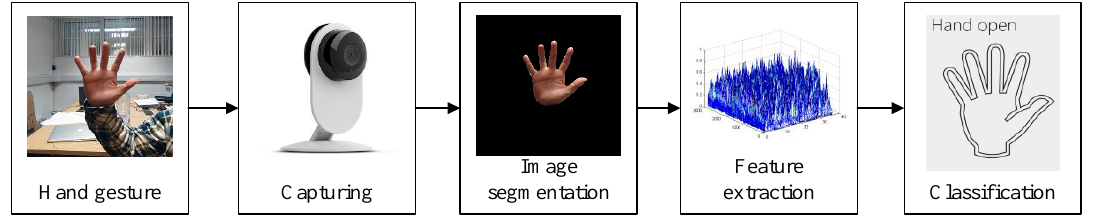
Figure 1. Process of hand gesture recognition.